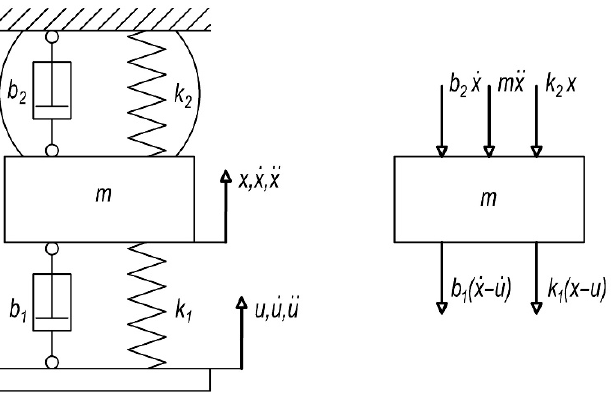
Figure 18. The simplified mechanical model loaded by the external force.